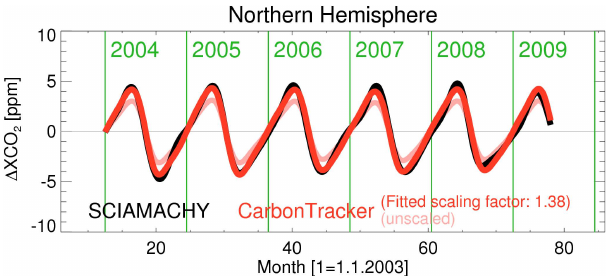
Fig. 4. Least-squares fit of CarbonTracker to SCIAMACHY XCO 2 for the Northern Hemisphere after subtraction of the deseasonalised trend with a scaling factor as fit parameter showing that an up- scaling of 38% is needed to fit the amplitude of the seasonal cycle of CarbonTracker to SCIAMACHY.